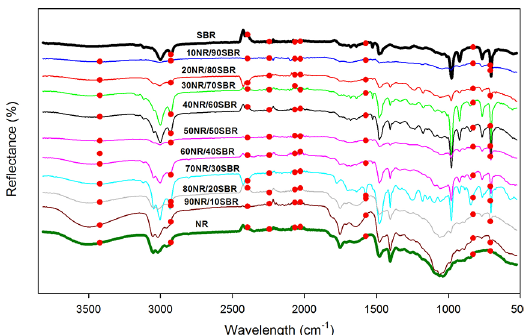
Figure 4. FTIR reflectance spectra of the analyzed NR/SBR blends. Full spectral data and 9 ( n = 11, n - 2 = 9) wavelengths automatically selected by the SPA algorithm. The red dots indicate the selected